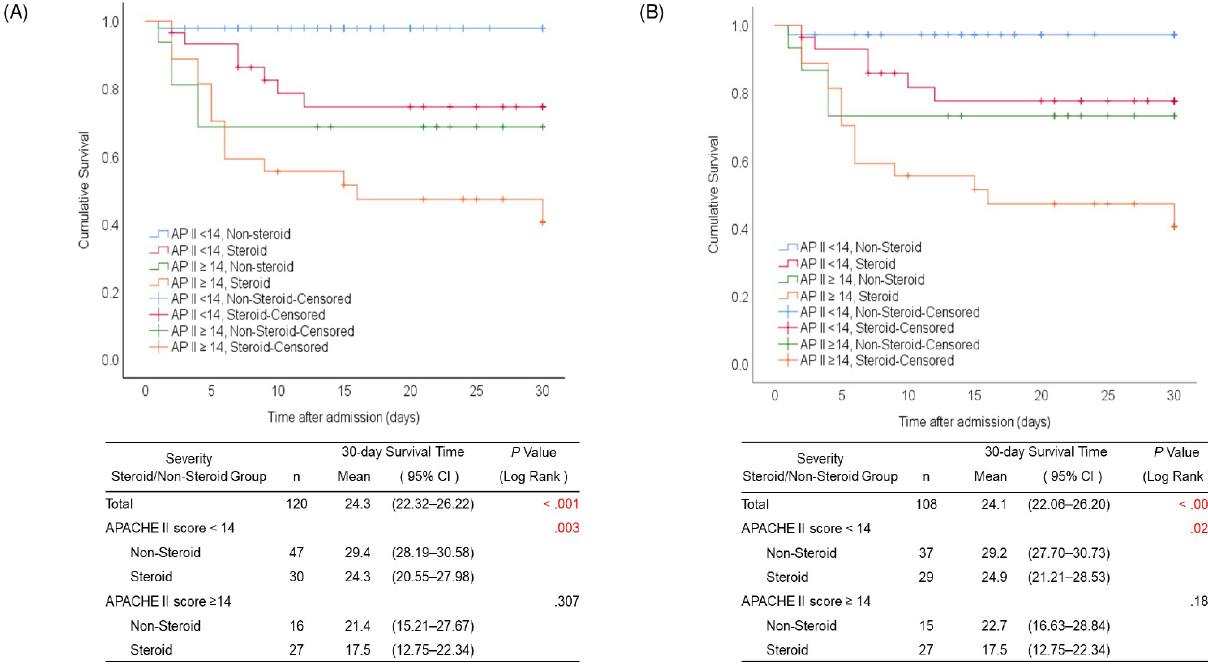
Fig 3. Survival analysis according to Acute Physiology and Chronic Health Evaluation (APACHE) II scores among patients with severe fever with thrombocytopenia syndrome (SFTS). (A) Kaplan–Meier 30-day survival analysis after admission of patients with severe fever with thrombocytopenia syndrome (SFTS) with and without steroid therapy according to SFTS severity before propensity score matching a . (B) Kaplan–Meier 30-day survival analysis of patients with severe fever with thrombocytopenia syndrome (SFTS) with and without steroid therapy according to SFTS severity after propensity score matching b . a. Twenty-two patients had missing data on the initial APACHE II score or 30-day survival time. b. Four patients had missing data on 30-day survival time.